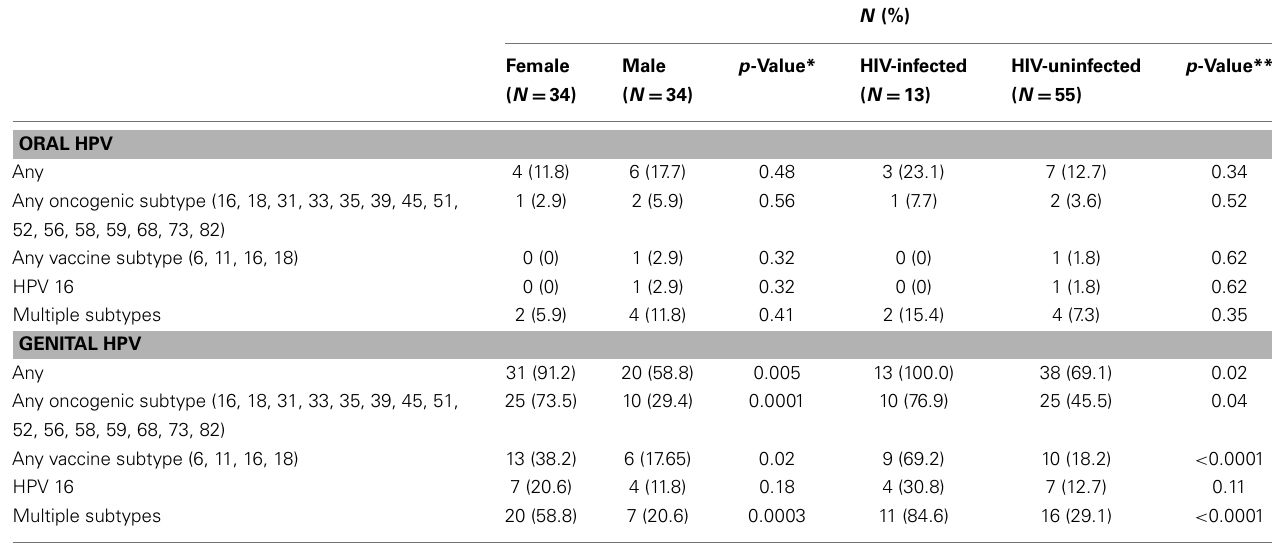
Table 2 | Oral and Genital HPV Prevalence by gender and HIV status